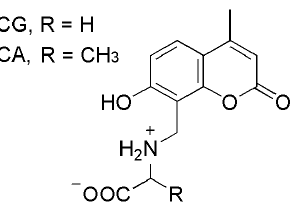
Figure 63. Chemical structure of CG and CA probes.